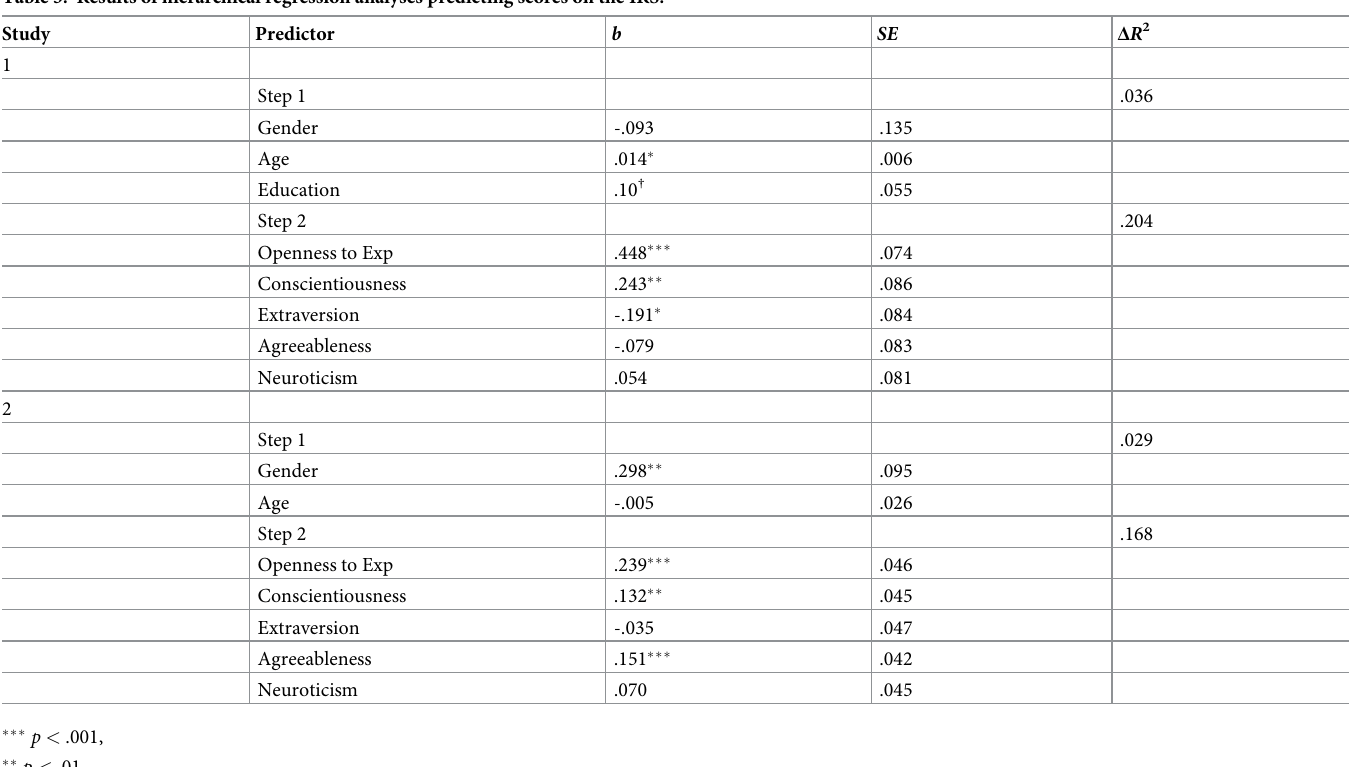
Table 3. Results of hierarchical regression analyses predicting scores on the